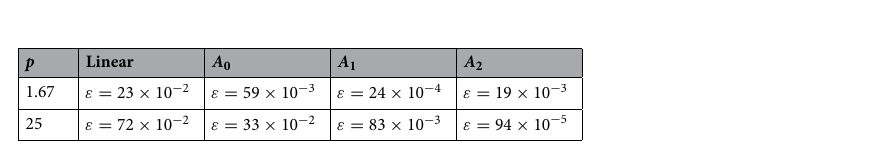
Table 1. Relative error for different approximations of amplitude.